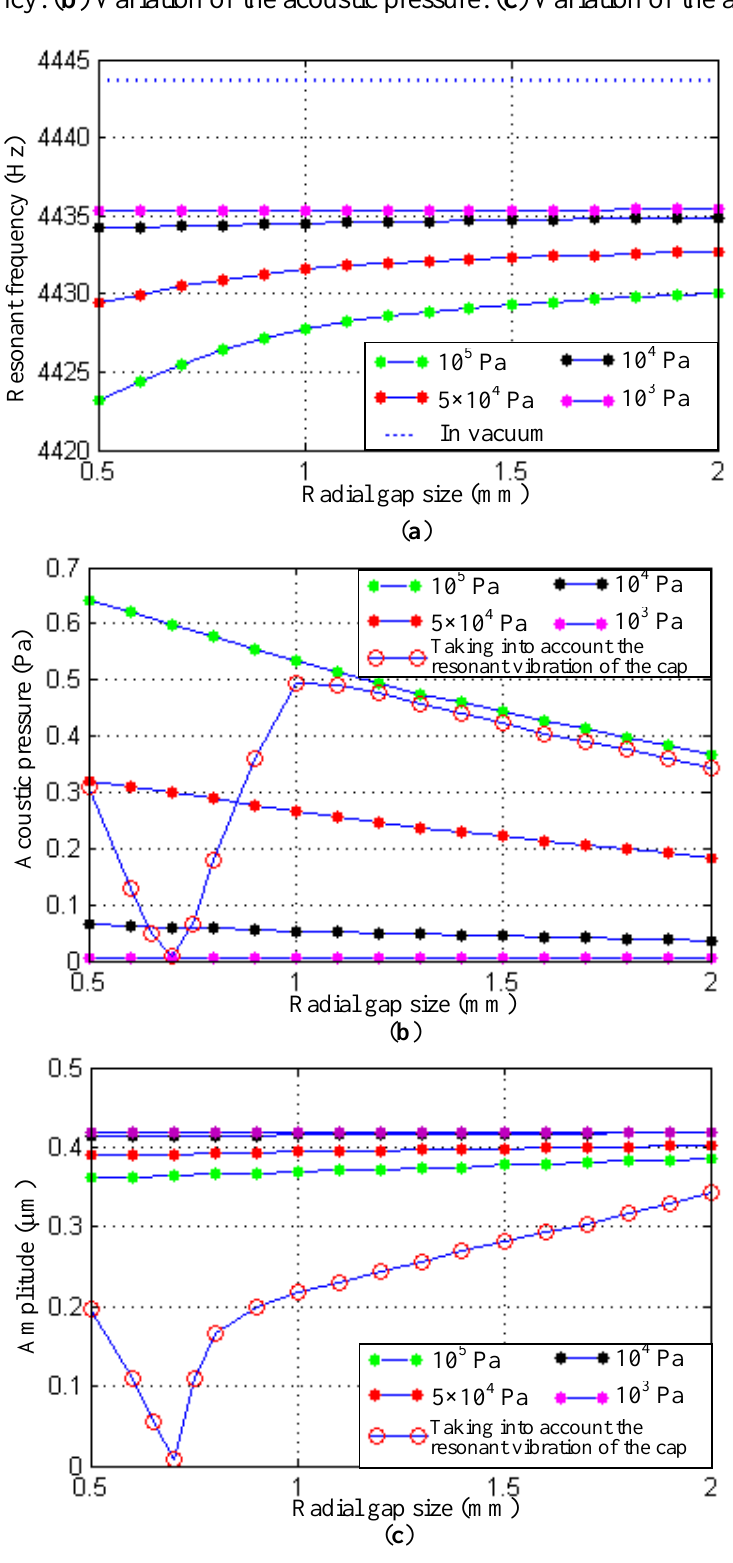
Figure 5. Acoustic effect under different radial gaps and vacuum degree. ( a ) Variation of the resonant frequency. ( b ) Variation of the acoustic pressure. ( c ) Variation of the